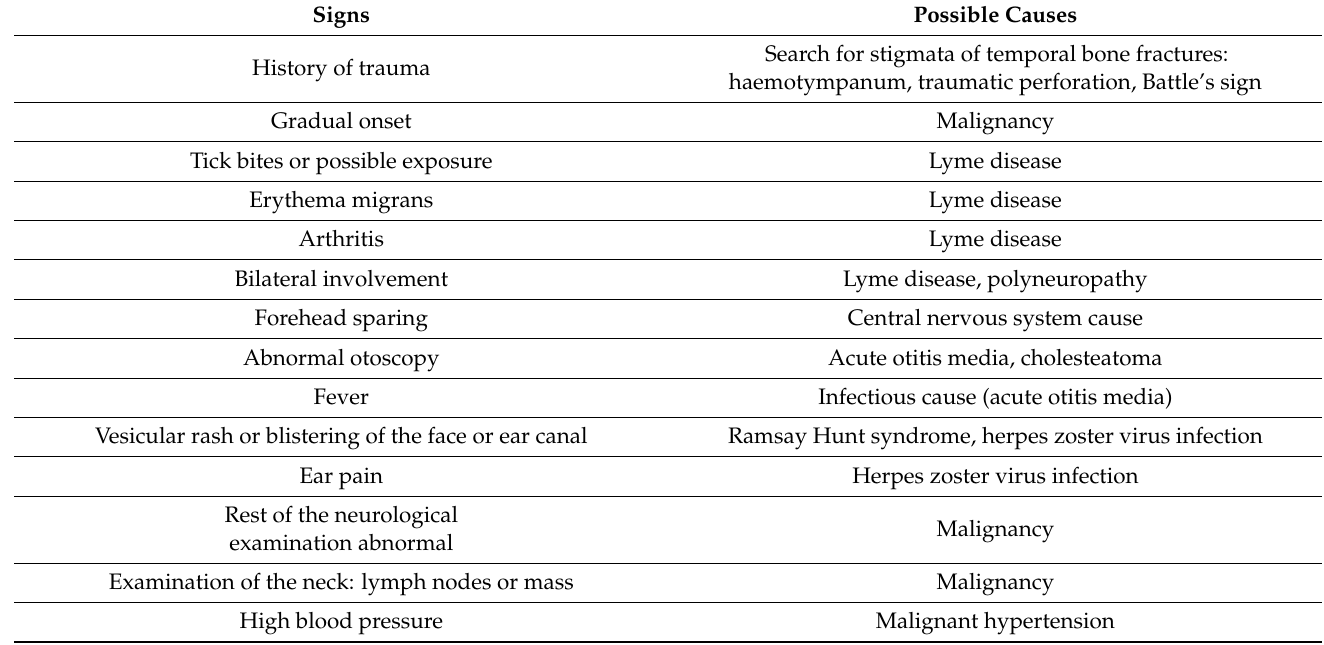
Table 2. Characteristic signs of specific causes of facial palsy.